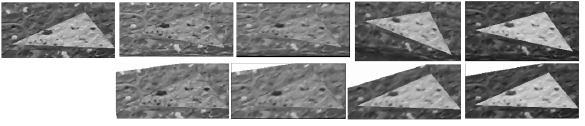
Figure 5. Upper-line: Correspondent ROIs on different images, left: ROI of master image. Lower-line: normalized ROI to master image